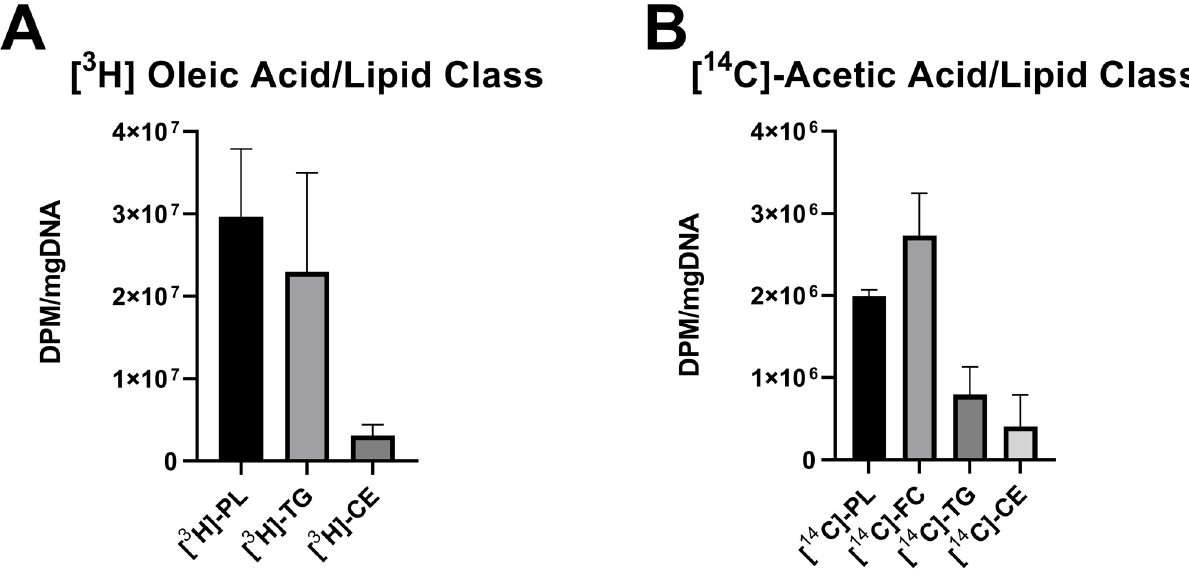
Fig 2. Lipid metabolic functionality in 3D human hepatic constructs. The hepatic construct was incubated with [ 3 H]-oleic acid and [ 14 C]-Acetic acid for 1.5 hours (n = 3) to quantify lipid esterification and lipogenesis functionality, respectively. (A) Formation of [ 3 H]-phospholipid (PL), [ 3 H]- triglyceride (TG), and [ 3 H]-cholesteryl ester (CE) from of [ 3 H]-oleic acid was measured to access the ability of fatty acid esterification. (B) De novo synthesis of [ 14 C]-PL, [ 14 C]-free cholesterol (FC), [ 14 C]-TG, and [ 14 C]-CE from [ 14 C]-acetic acid were measured fractions. Scintillation counts were normalized to total DNA, and mean ± SEM are illustrated. DPM, disintegrations per minute.